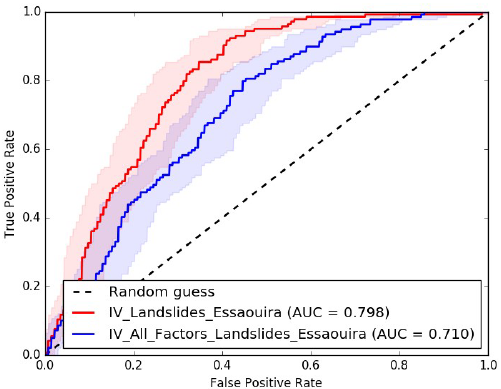
Figure 11. ROC curves of the susceptibility model for all landslides with all factors (AUC = 0.710) and without TWI and rainfall factor (AUC = 0.798).